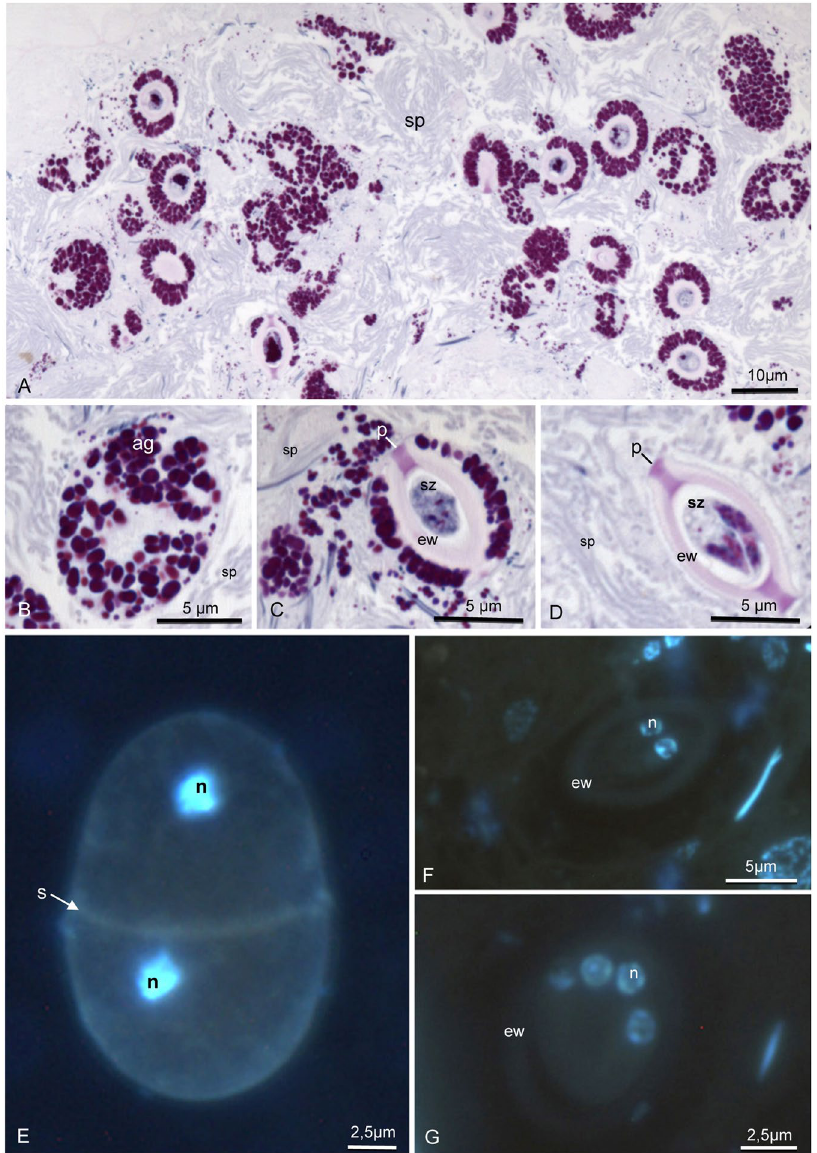
Figure 3. Histological section of contaminated seminal vesicle submitted to periodic acid-Schiff (PAS) reaction ( A–D ), and parasites stained with DAPI ( E–G ). ( A–D ) Gregarines in different stages exhibiting amylopectin granules (ag) in strong purple color. Note in oocytes ( C,D ) the presence of plugs (p) on the both poles and internally the sporozoites (sz). Spermatozoa (sp); extracellular wall (ew). ( E ) Gamont stage; Note the presence of two nuclei (n) and a septum (s). ( F,G ) Oocytes showing two ( F ) and four ( G ) sporozoites surrounded by a thick wall